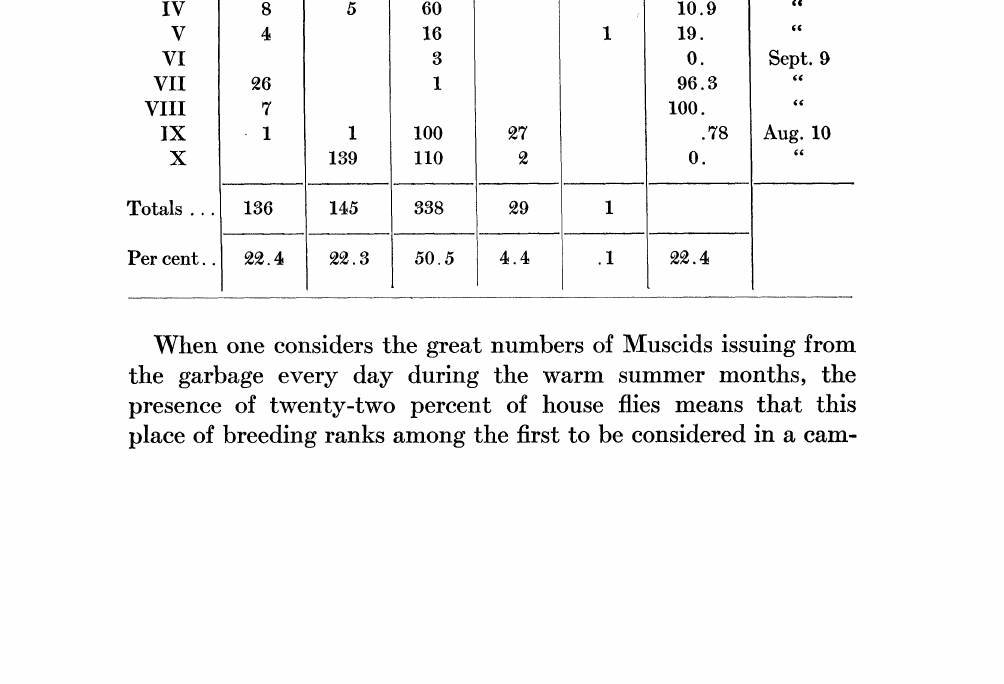
TABLE OF REARINGS SHOWING NUMBER AND PROPORTION OF EACH SPECIES COLLECTED. Number of specimens. Date of Percentage Musca Phor- Lucilia Calli- Muscina Lot No. phora of house stabu- domes- mia seri- erythro- lans. flies. regina, cata. tica. cephala.